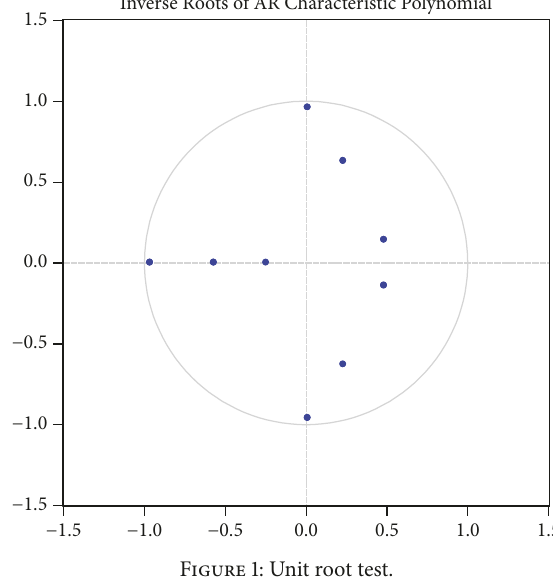
Figure 1: Unit root